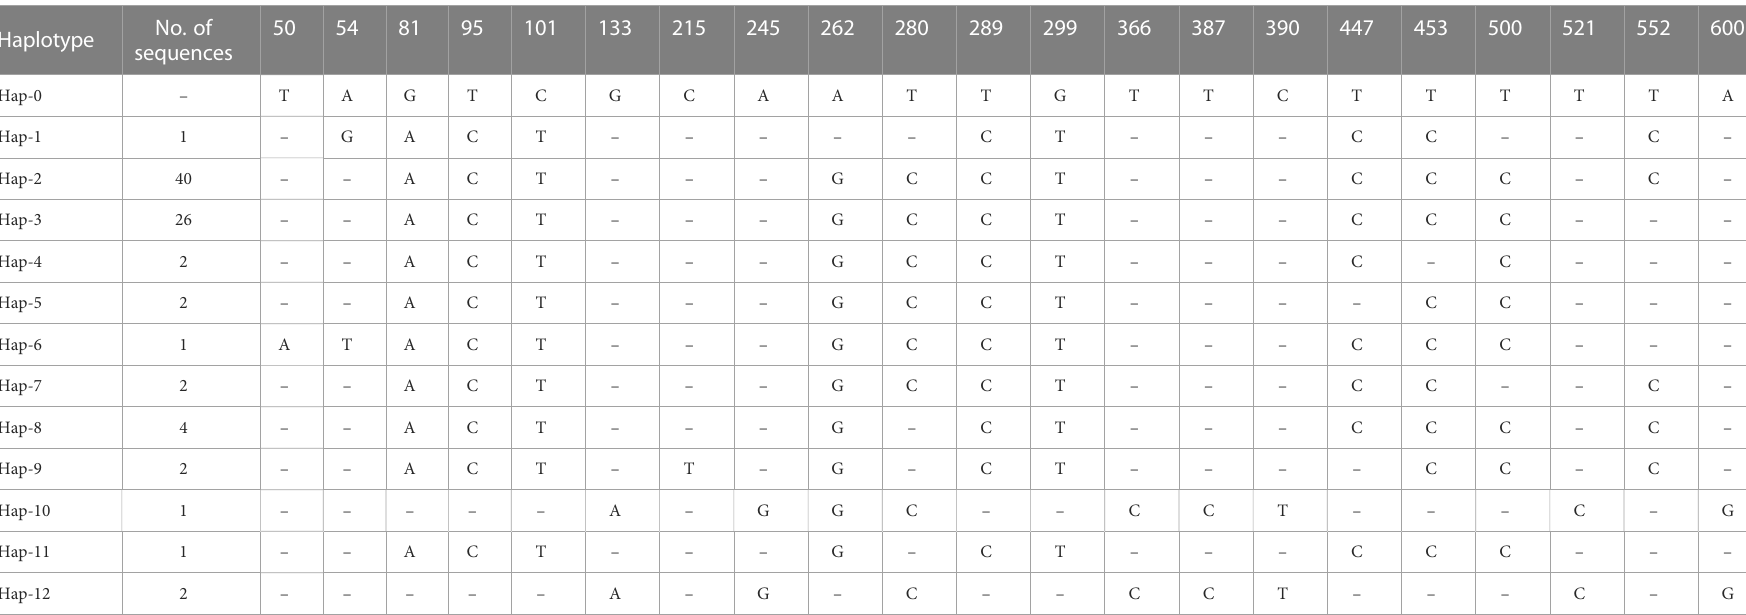
TABLE 4 Haplotypes identi fi ed in the 704bp mitochondrial D- loop sequences, along with sample size.